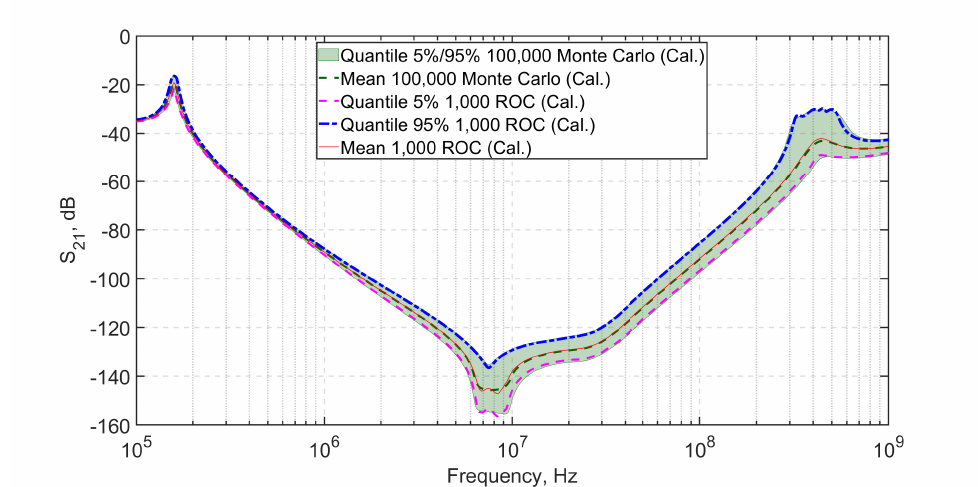
Figure 14. Filtering performances: 5%/95% confidence intervals from Test case #1/Channel #4 including MC samples and ROC calculations.